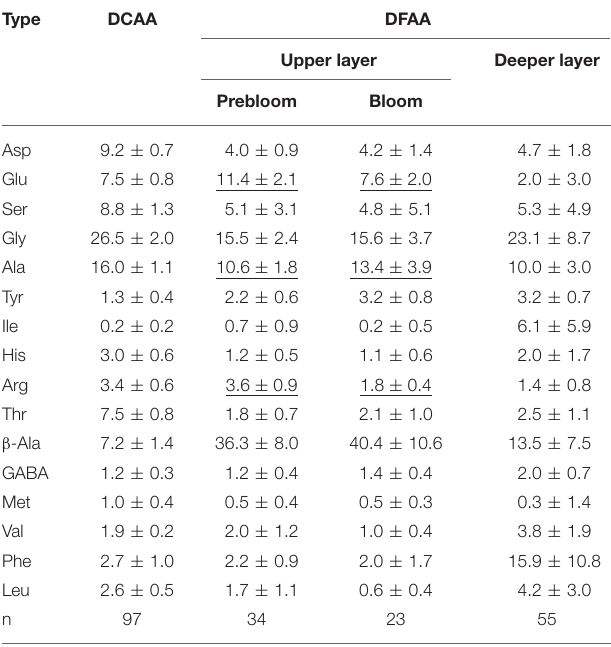
TABLE 2 | Mole% of individual amino acids.